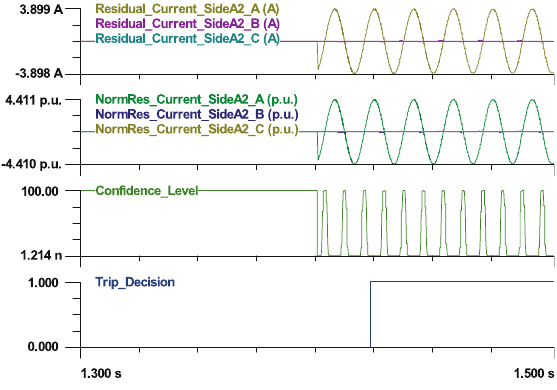
Fig. 11 EBP relay performance of event 2: internal high impedance fault, grid-connected